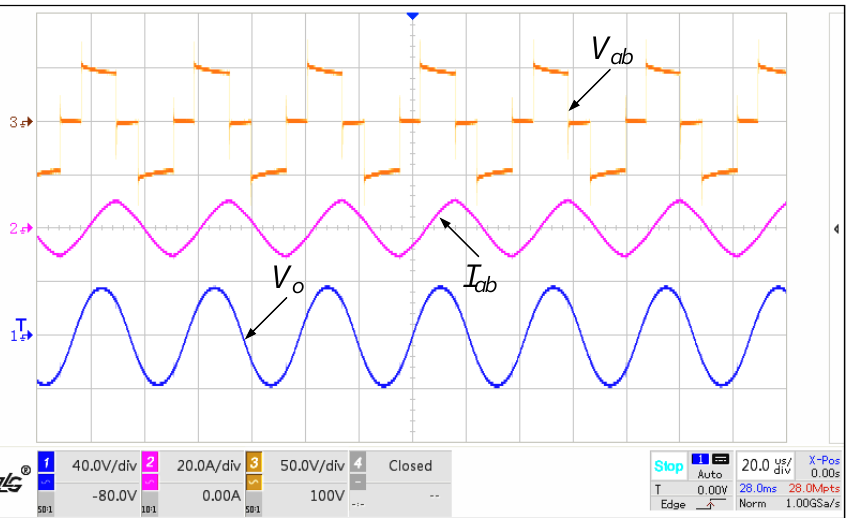
Figure 15. Experimental waveforms of the output voltage V o , resonant current I ab and output bridge arm voltage V ab .